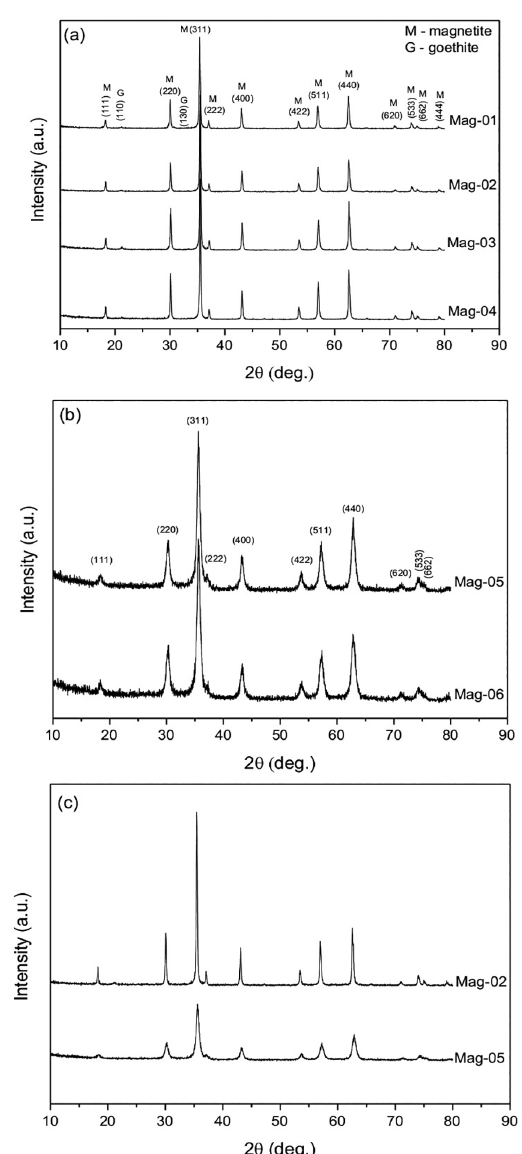
Figure 1. X-ray diffractograms of samples (a) Mag-01 to Mag-04, (b) Mag-05 to Mag-06 and (c) a plot showing the differences in diffraction intensity between the two routes